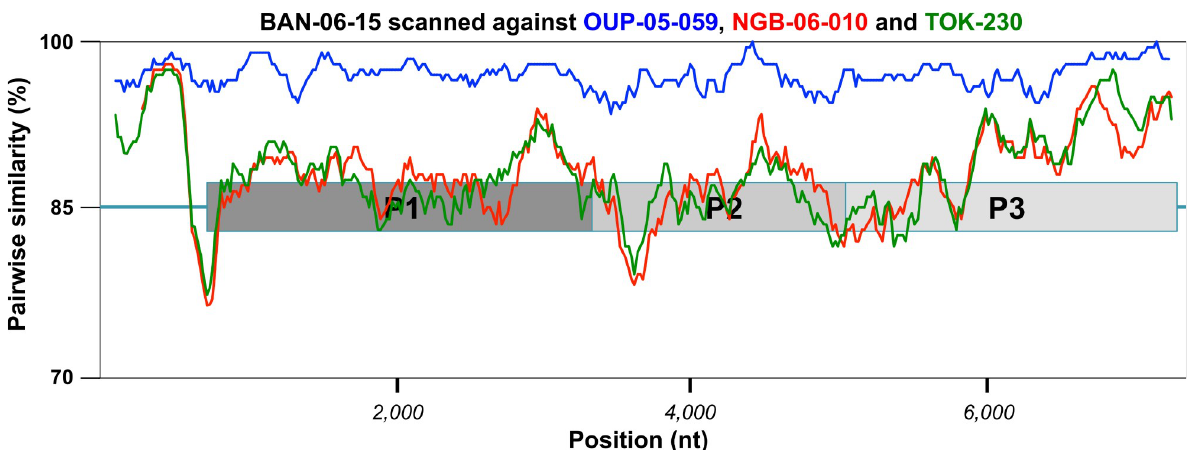
Fig 1. Comparative analysis of the four EV-D111 full-length genomes. A similarity plot was drawn by comparing the genomic sequence of the strain BAN-06-150 with those of the four other EV-D111 strains sequences in this study.